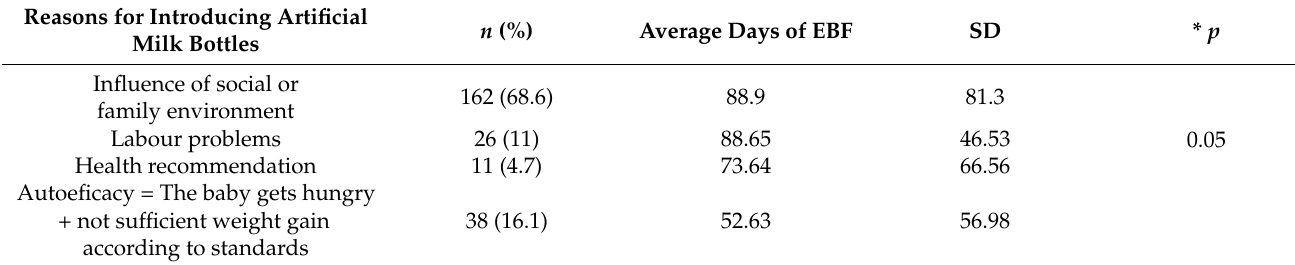
Table 5. Reasons cited by mothers for ceasing exclusive breastfeeding. Multivariate analysis (women who practiced exclusive breastfeeding some time for 6